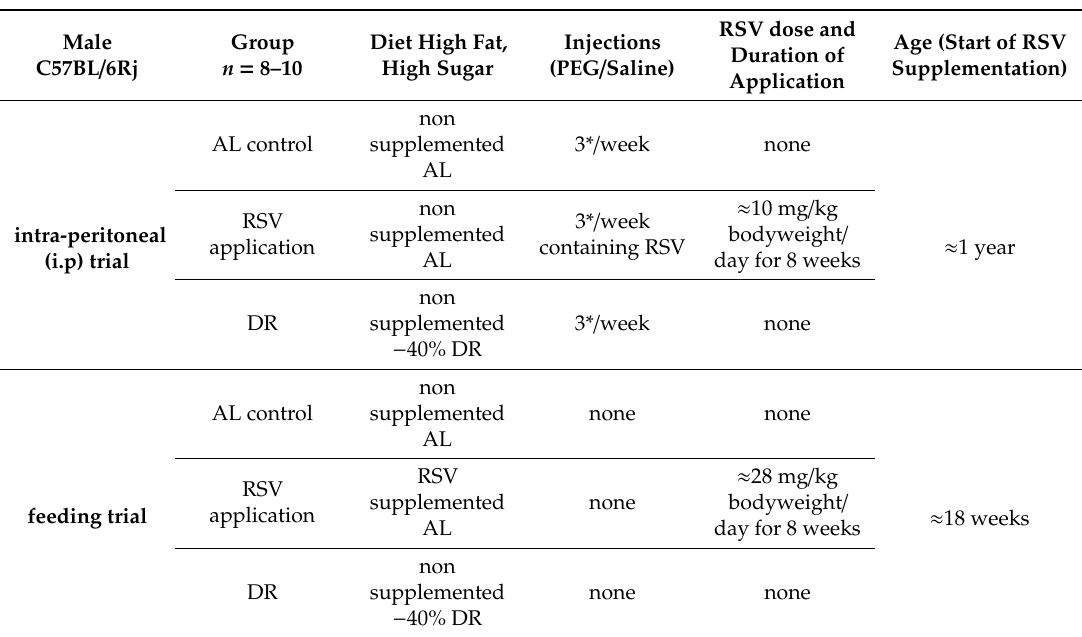
Table 1. Experimental design used showing how the three groups per trial (ad libitum (AL) control without resveratrol (RSV) application, RSV application group and − 40% DR group) were treated and what / how many mice were used. Dietary restriction (DR) was introduced gradually and mice were subjected to a six-week adaptation period on the high fat, high sugar diet before beginning the trial